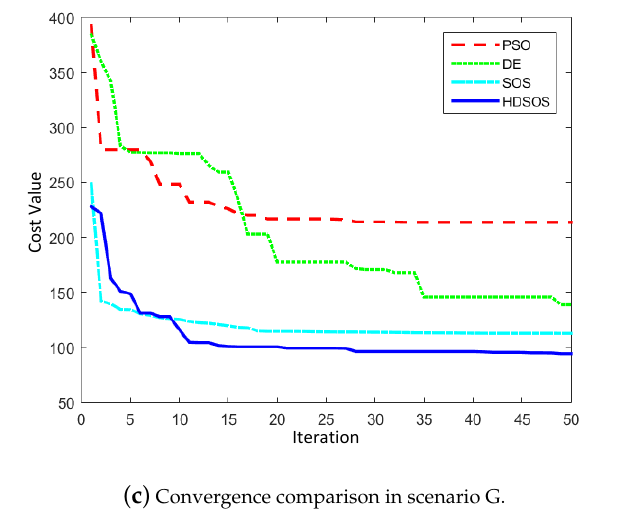
Figure 12. The comparative results for three-dimensional scenario